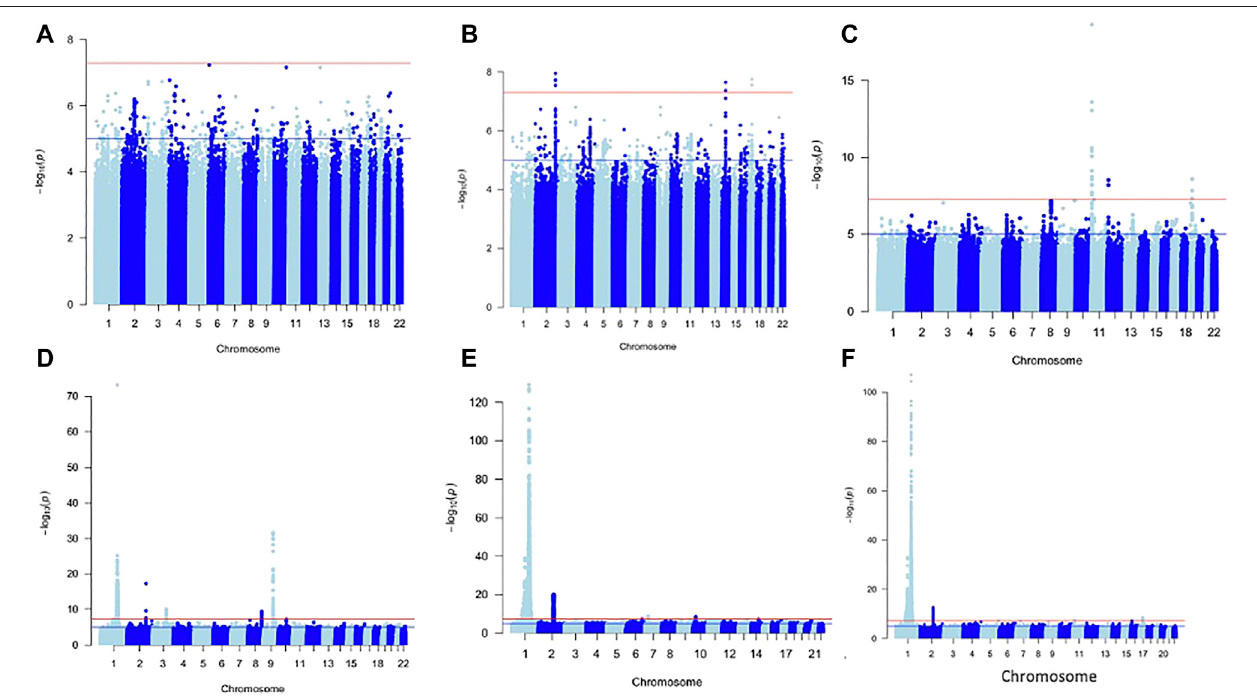
FIGURE 1 | Manhattan plot of metanalysis results of Baso (A) , Eos (B) , Lym (C) , Mon (D) , Neu (E) , and WBC (F) .